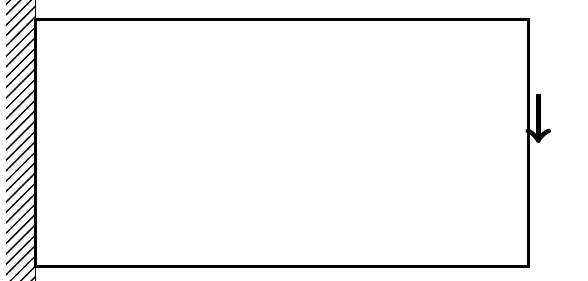
Figure 6. Conditions for Cantilever Beam.